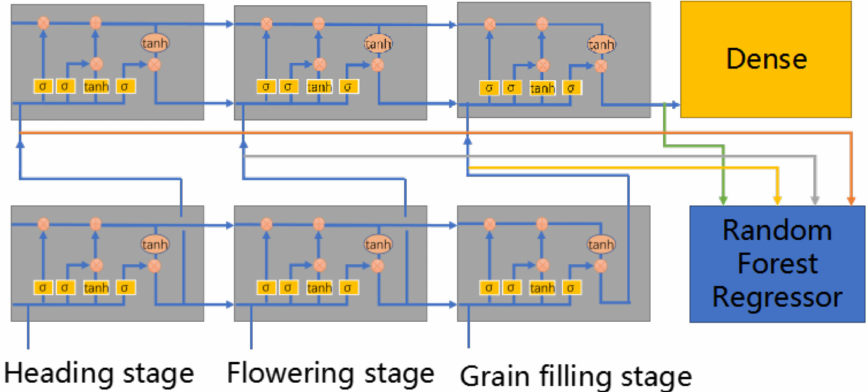
Figure 5. Structure of LSTM-RF.